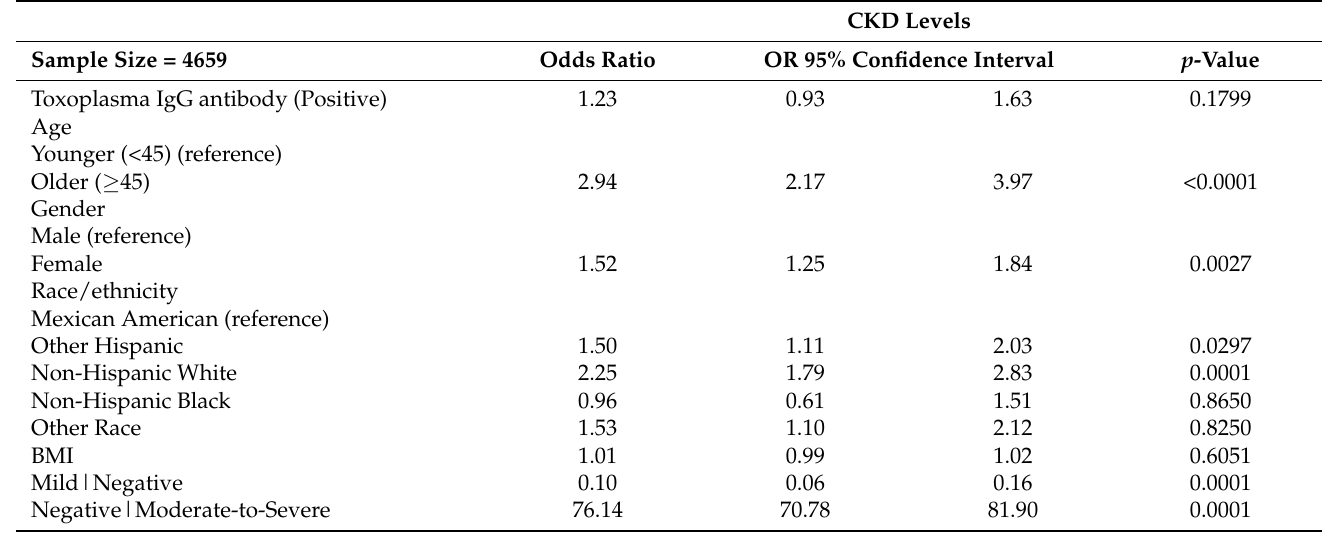
Table 10. Ordinal Logistic regression model for CKD levels on T. gondii IgG antibody (posi- tive/negative) adjusted for the demographic factors and BMI.